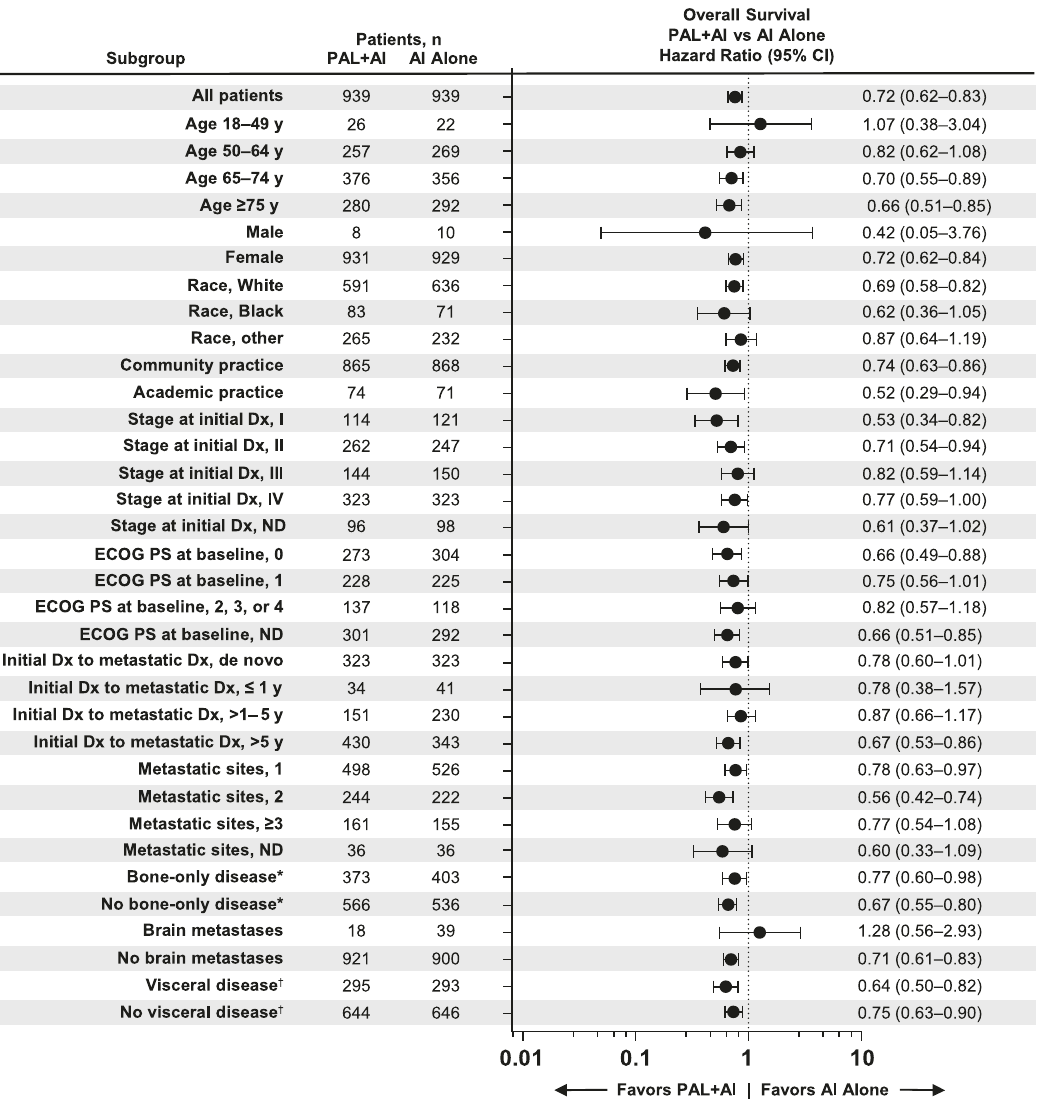
Fig. 4 Forest plot of overall survival by subgroup after PSM. AI aromatase inhibitor; Dx diagnosis; ECOG PS Eastern Cooperative Oncology Group performance status; ND not documented; PAL palbociclib; PSM propensity score matching. * Bone-only disease was de fi ned as metastatic disease in the bone only. † Visceral disease was de fi ned as metastatic disease in the lung and/or liver; patients could have had other sites of metastases. No visceral disease was de fi ned as no lung or liver